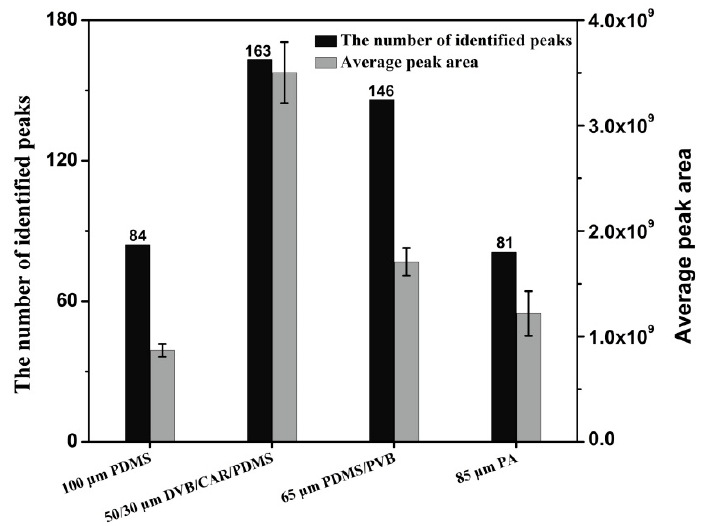
Figure 2. Comparison of aroma amounts and peak areas in pears using four different SPME fibres.